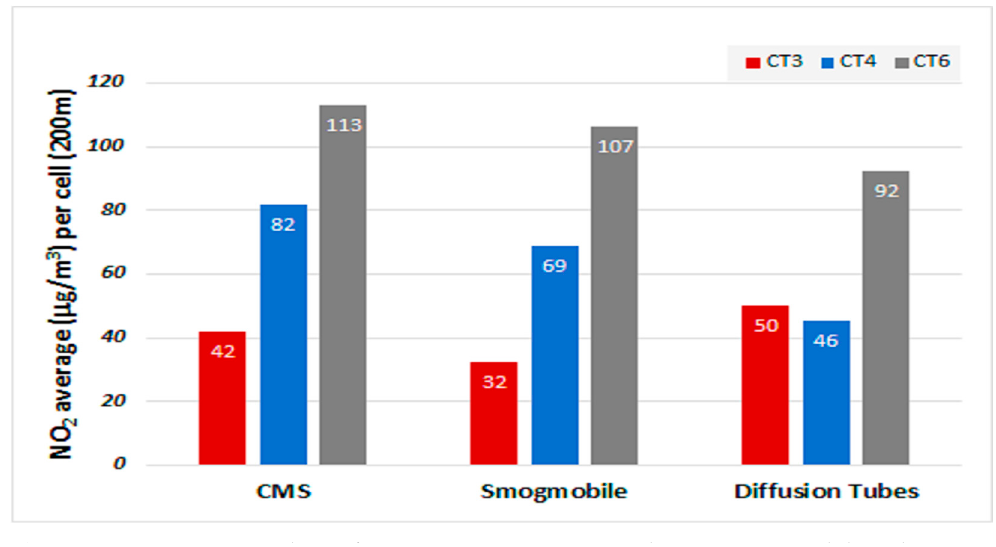
Figure 10. Comparative analysis of average NO 2 concentrations between Smogmobile and CoL monitoring systems (CMS).